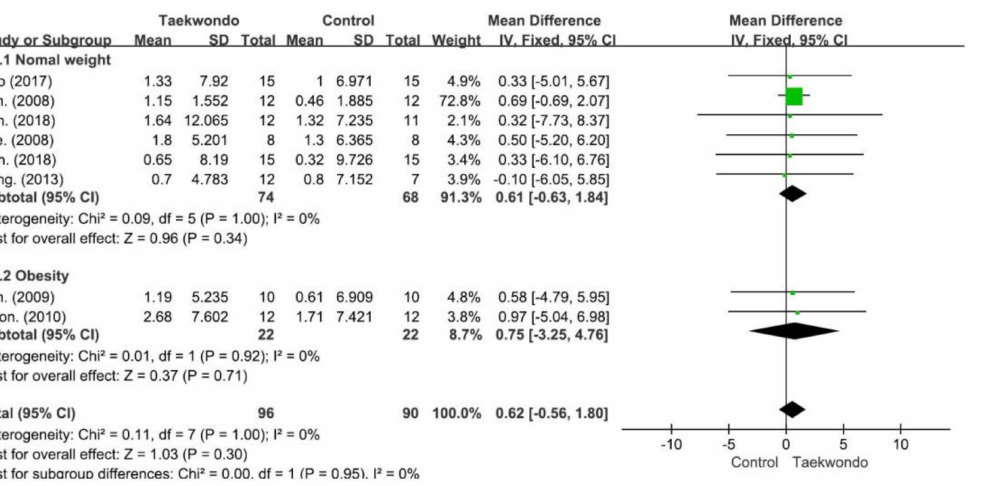
Figure 5. Forest plot depicting differences in the change-from-baseline height between the taekwondo and control groups. CI: confidence interval and SD: standard deviation. (Cho. 2017 [38]; Kim. 2008 [29]; Koh. 2018 [34]; Lee. 2008 [39]; Roh. 2018 [40]; Song. 2013 [36]; Kim. 2009 [30]; Kwon 2010 [33]).